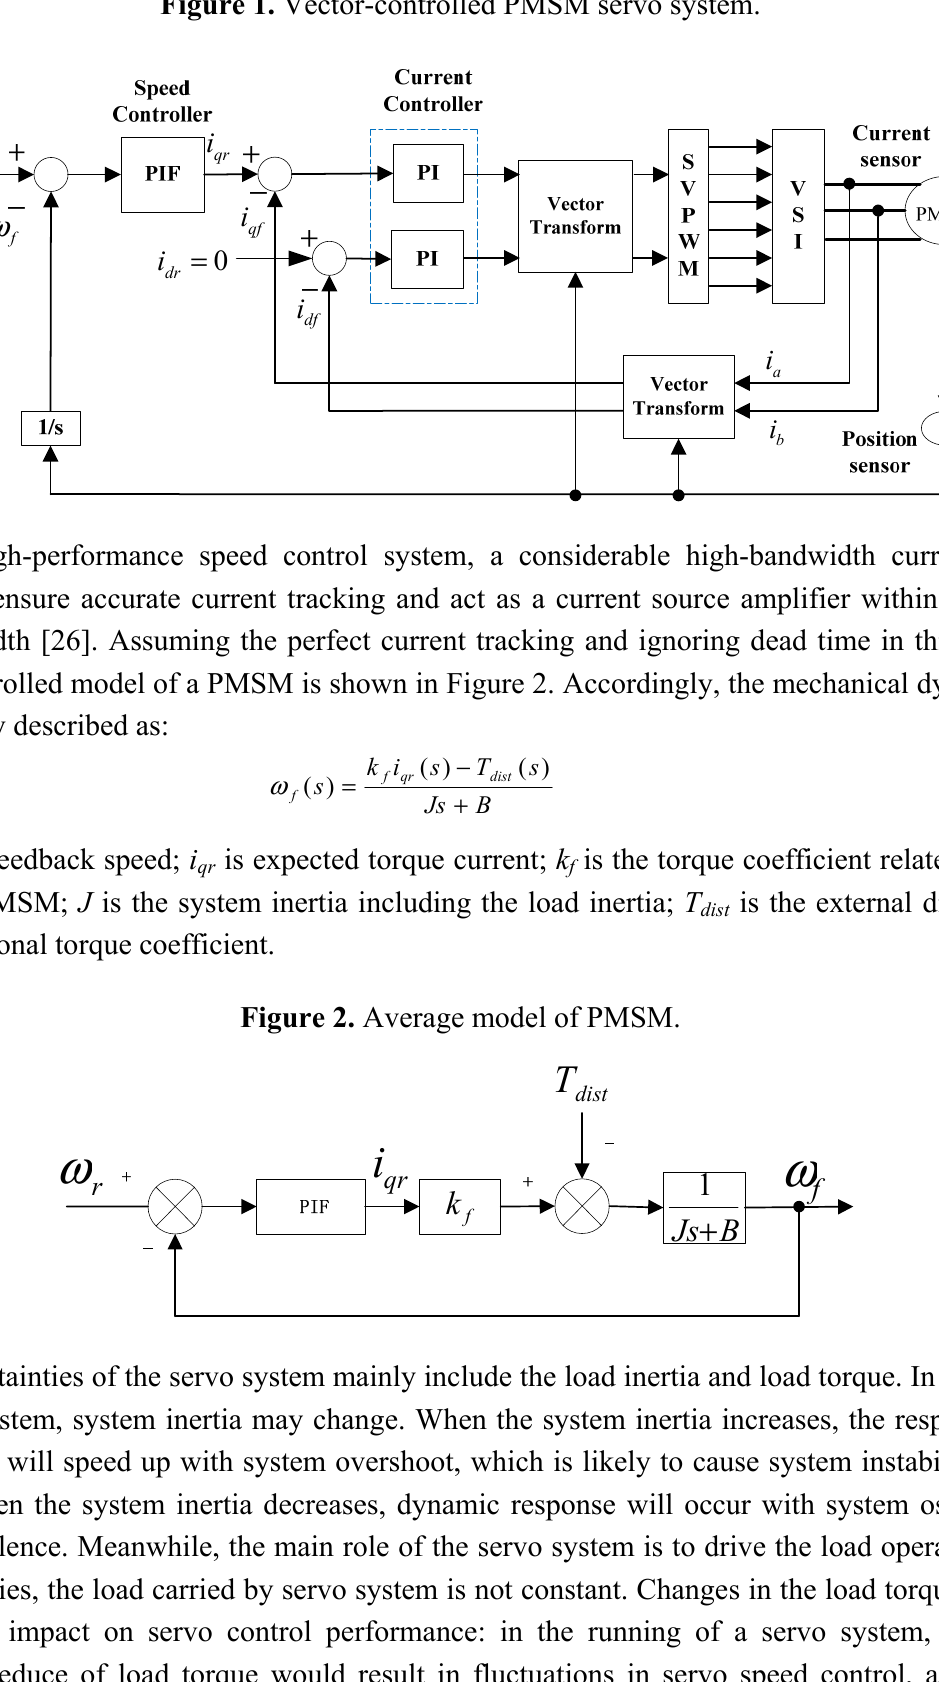
Figure 1. Vector-controlled PMSM servo system.